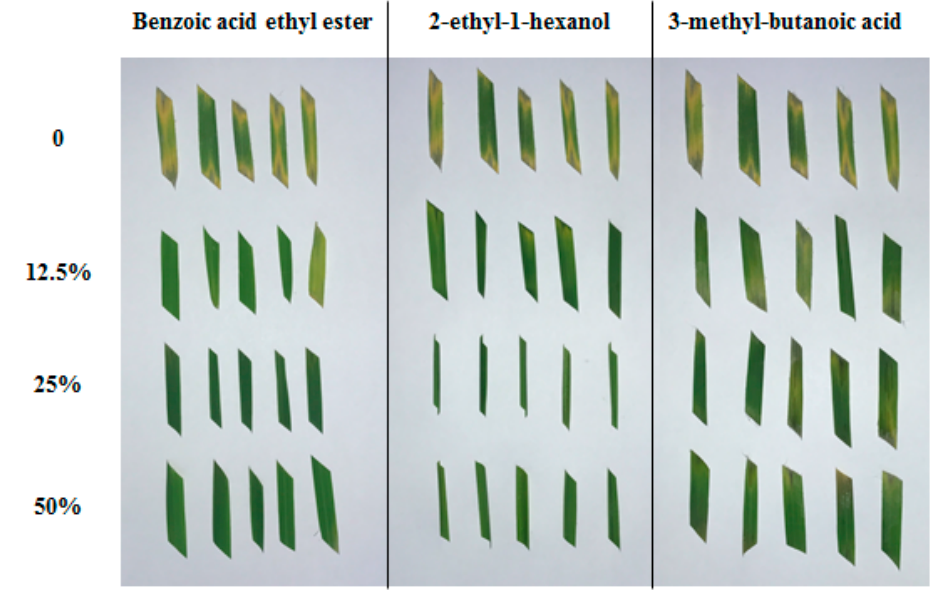
Figure 5. The inhibitory effect of pure substances on R. solani . 25% concentration was 50 µ L sterile water/plate ( A ), 50% concentration was 100 µ L pure substances and 100 µ L sterile water/plate ( B ), and 100% concentration was 200 µ L of pure chemical substance/plate ( C ). CK was 200 µ L sterile water/plate. ( D ): Chemical structures of purified compounds.